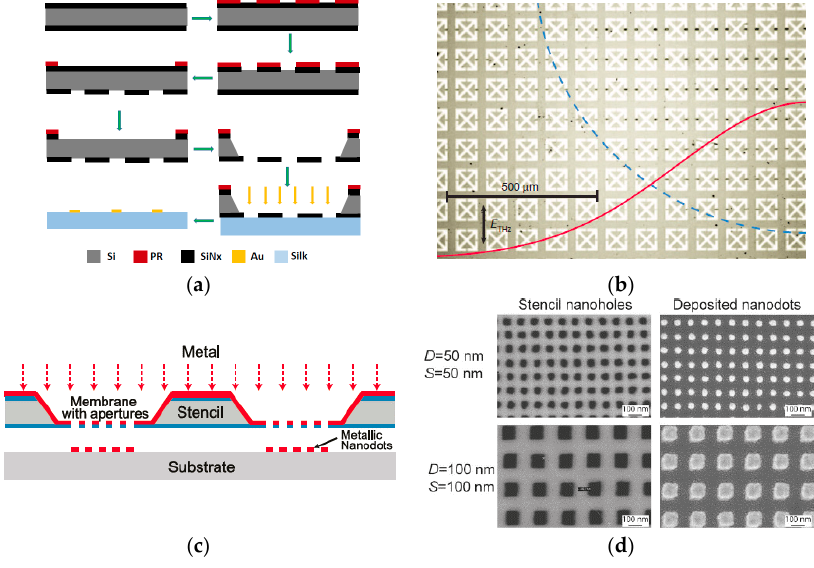
Figure 1. ( a ) Fabrication process of a SiN x stencil mask for silk-based sensing platform; ( b ) micrograph of a metamaterials sensor fabricated by using SiN x -based stencil lithography. Reprinted by